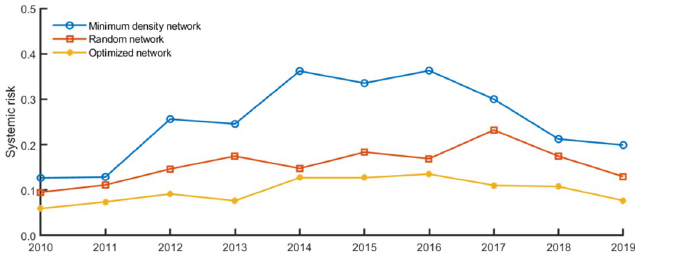
Fig 6. The overall systemic risk of the network before and after optimization.